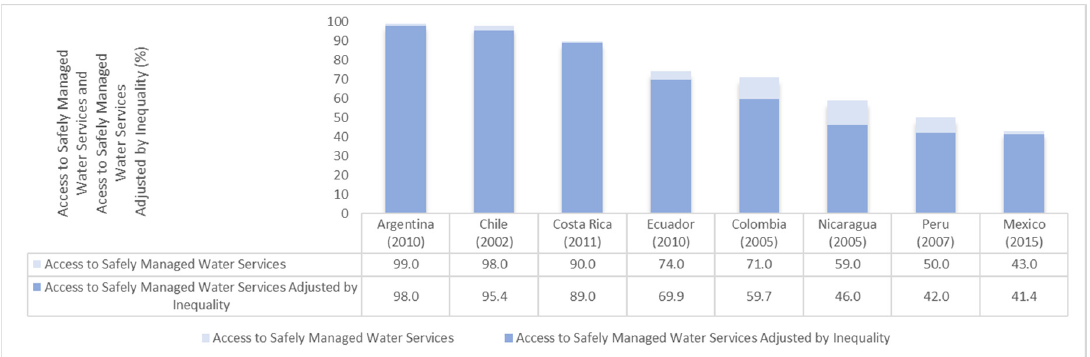
Figure 3. Access to safely managed water services and access to safely managed water services adjusted by inequality. Source: Own elaboration based on census microdata from the IPUMS-International Project [25].